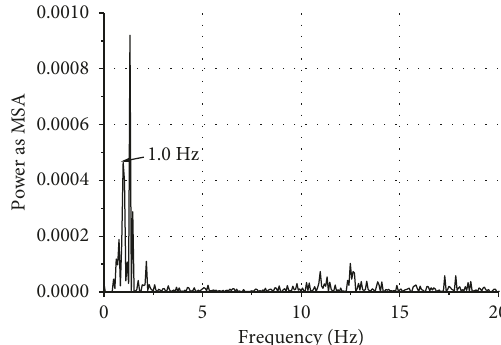
Figure 18: PSD calculation